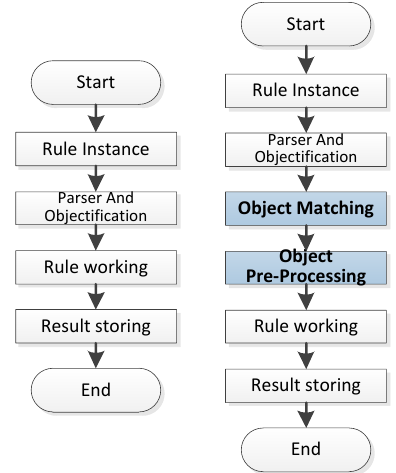
Figure 4 Inspect Rule Working Under Achievement Dimension And Project